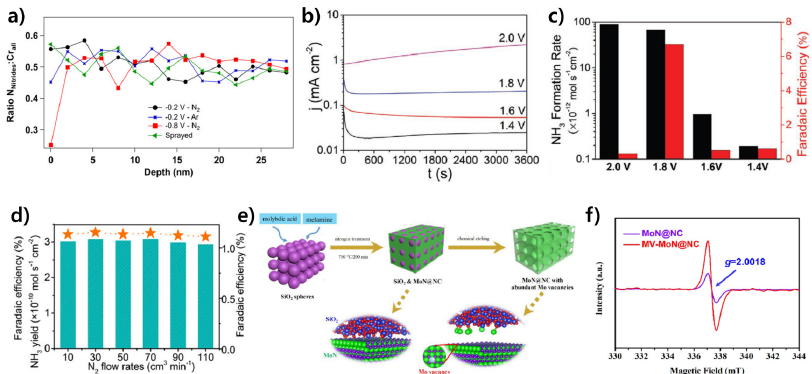
Figure 4. ( a ) The ratio of N to Cr in spent catalysts (Cr 2 N) through XPS-depth pro fi ling. ( b ) J-t curves for 3 h at di ff erent potentials on CrO 0 . 66 N 0 . 56 . ( c ) NH 3 formation rate with faradaic e ffi ciency using CrO 0 . 66 N 0 . 56 . ( d ) NH 3 yields and FEs with di ff erent N 2 fl ow rates on MoN/CC at − 0.3 V. ( e ) Schematic illustration of MV-MoN@NC synthesis through the sacri fi cial-hard-template route. ( f ) EPR spectra of MV-MoN@NC and MoN@NC based on g = 2.0018. Reproduced with permission from the Amer-